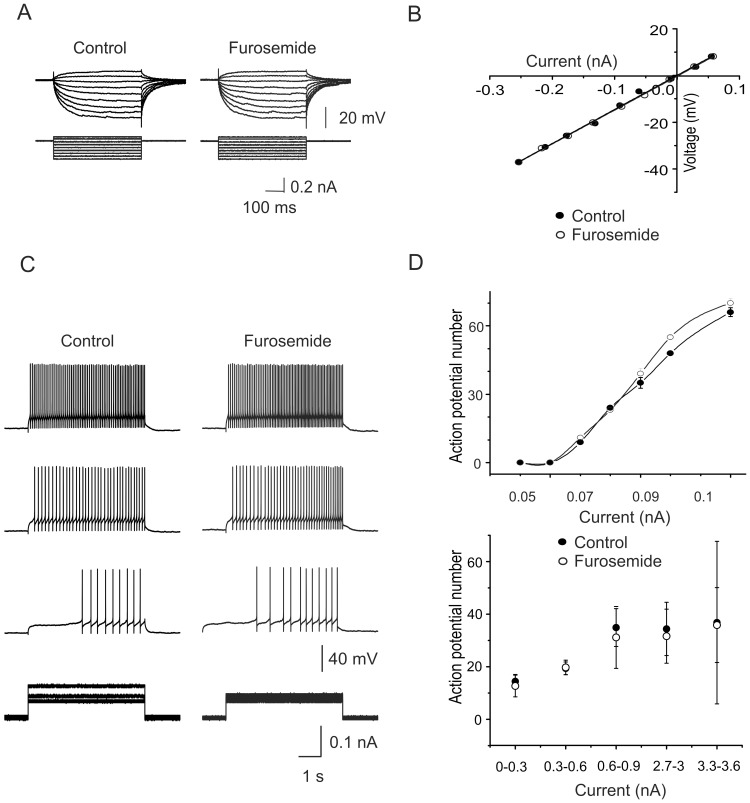
Furosemide non-sensitive GABAA receptors.A) Current-voltage responses recorded intracellularly from one motoneuron in control Ringer and in the presence of furosemide (200 µM). B) I-V curves obtained as in A. C) AP firing in response to different depolarizing intracellular current pulses recorded in control Ringer and in the presence of furosemide (200 µM). D) Plot of the depolarizing current pulses versus the number of action potentials evoked in one cell (upper panel) and a group of cells (lower panel) in control Ringer and in the presence of furosemide. All the recordings were obtained in the presence of strychnine (2 µM), CNQX (20 µM) and APV (20 µM).